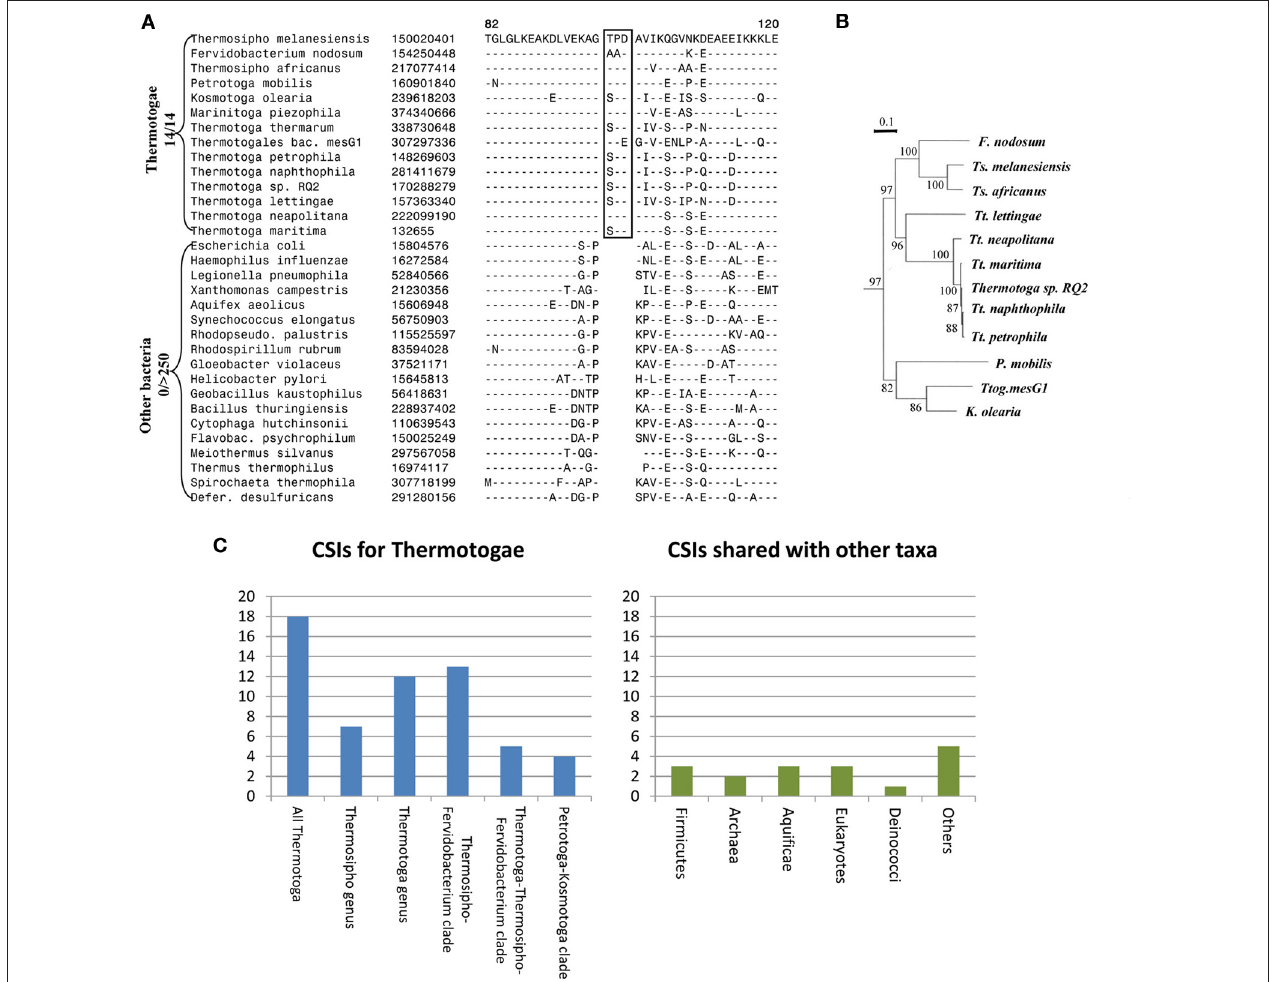
FIGURE 1 | Evolutionary relationships among Thermotogae species based upon CSIs and a Phylogenetic Tree. (A) Partial sequence alignment for the ribosomal protein L7 showing a 3aa CSI (boxed) that is specific for all detected species of the Thermotogae phylum. The dashes in the alignment ( − ) indicate amino acid identity with the corresponding residue in the top line; (B) A maximum likelihood tree for the 12 sequenced Thermotogae species based upon concatenated